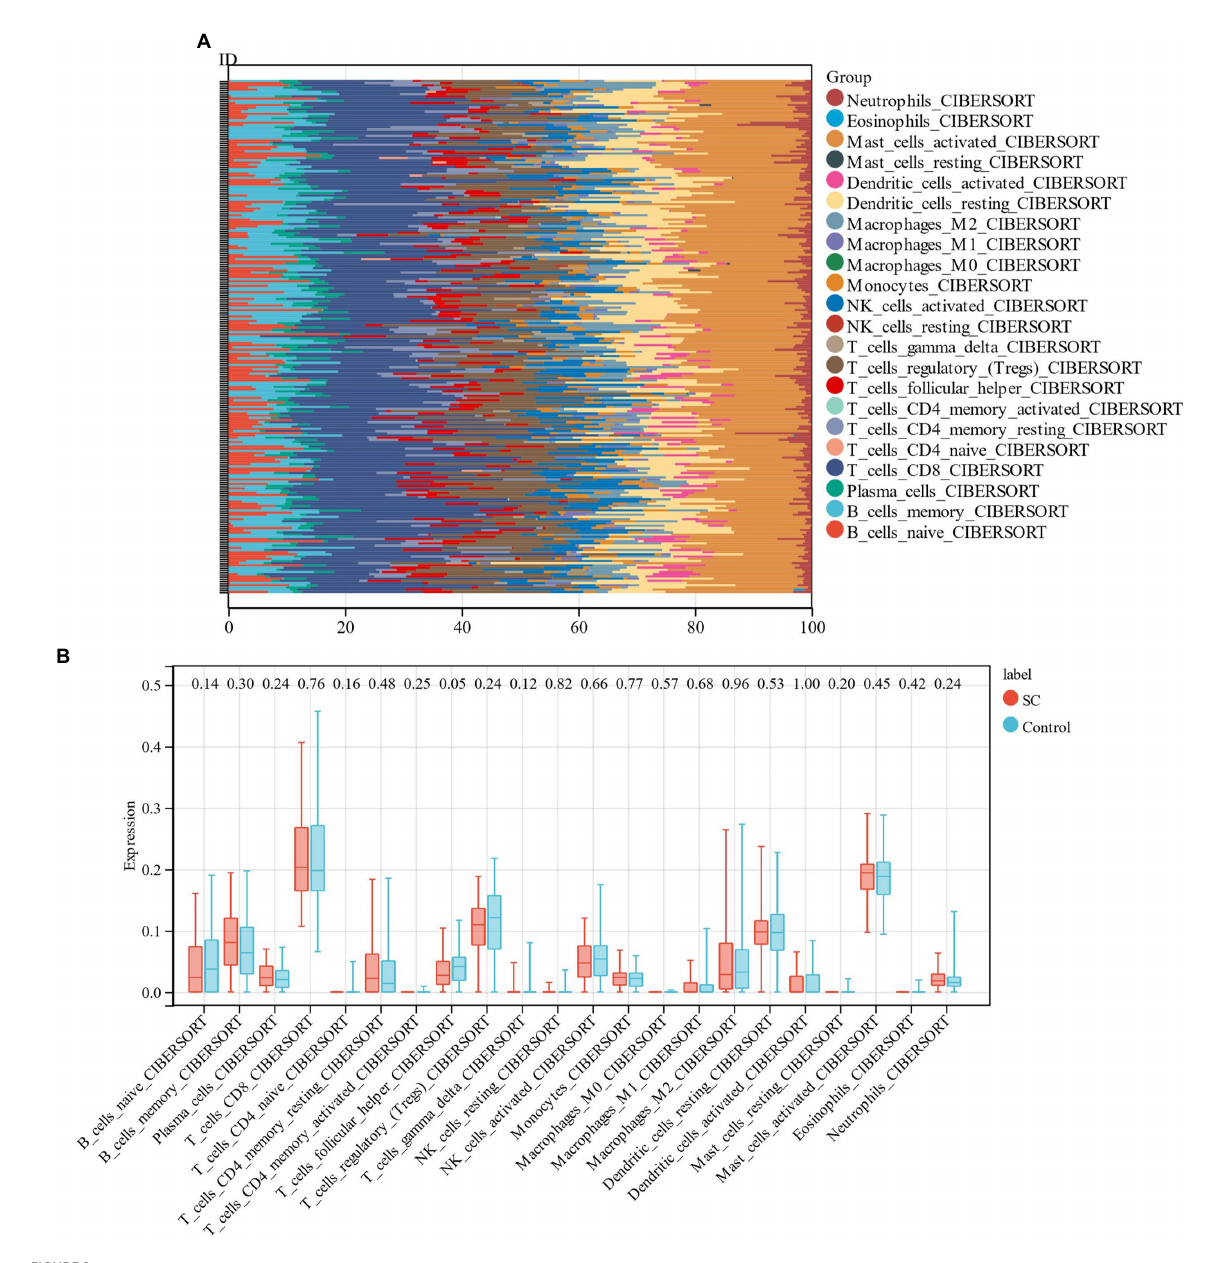
FIGURE 9 (A) Relative percentage of 22 immune cells in each sample; (B) : The difference in immune infiltration between schizophrenia samples and control